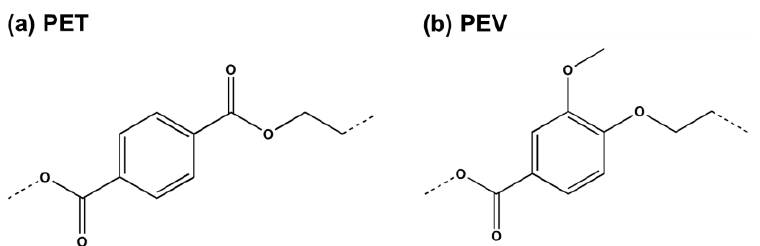
Figure 1. Two-dimensional structures of the two single-chain polymers: ( a ) polyethylene terephthalate (PET or T) and ( b ) polyethylene vanillate (PEV or V) for PET/PEV blends.